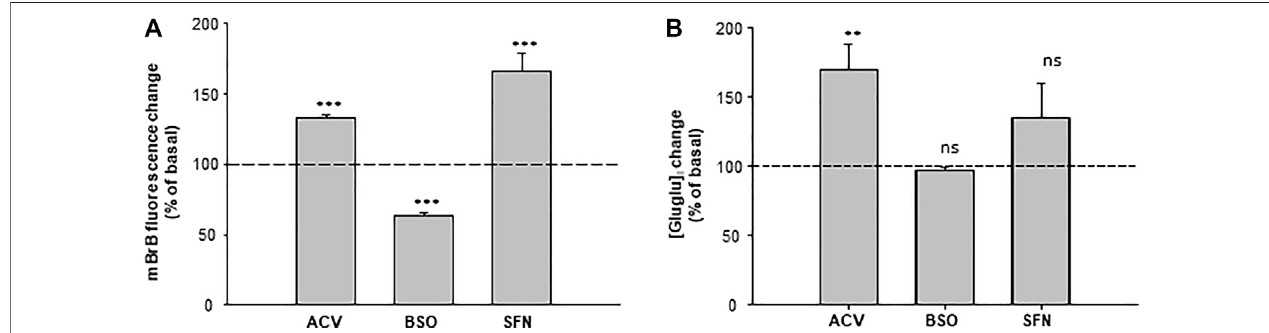
FIGURE 5 | Quanti fi cation of γ -Glu-Glu in the extracellular medium of astroglioma C6 cells. (A) [GSH] i content in the control, BSO-, ACV-, and SFN- pretreated C6 cells. GSH was measured in cellulo with monobromobimane (mBrB) 24 h following the treatments. On the graph, data are presented as percentages of mBrB fl uorescence intensity normalized to basal mBrB fl uorescence measured in the control-untreated cells. *** p < 0.001 when comparing mBrB fl uorescence measured in the control cells with either treatment (one-way ANOVA followed by the Holm – Sidak t-test). (B) Measurement of [ γ -Glu-Glu] in the extracellular medium ofC6 cells. Analysis of the C6 extracellular medium was performed on 100 µl samples of the culture medium of cells treated with BSO, ACV, and SFN. On the graph, [ γ -Glu-Glu]e has been normalized to [ γ -Glu-Glu]e detected in the control-untreated cells. ** p < 0.01 and “ not signi fi cant ” (ns) when comparing [ γ -Glu-Glu]e measured in control cells with either treatment (one-way ANOVA followed by the Holm – Sidak t-test).